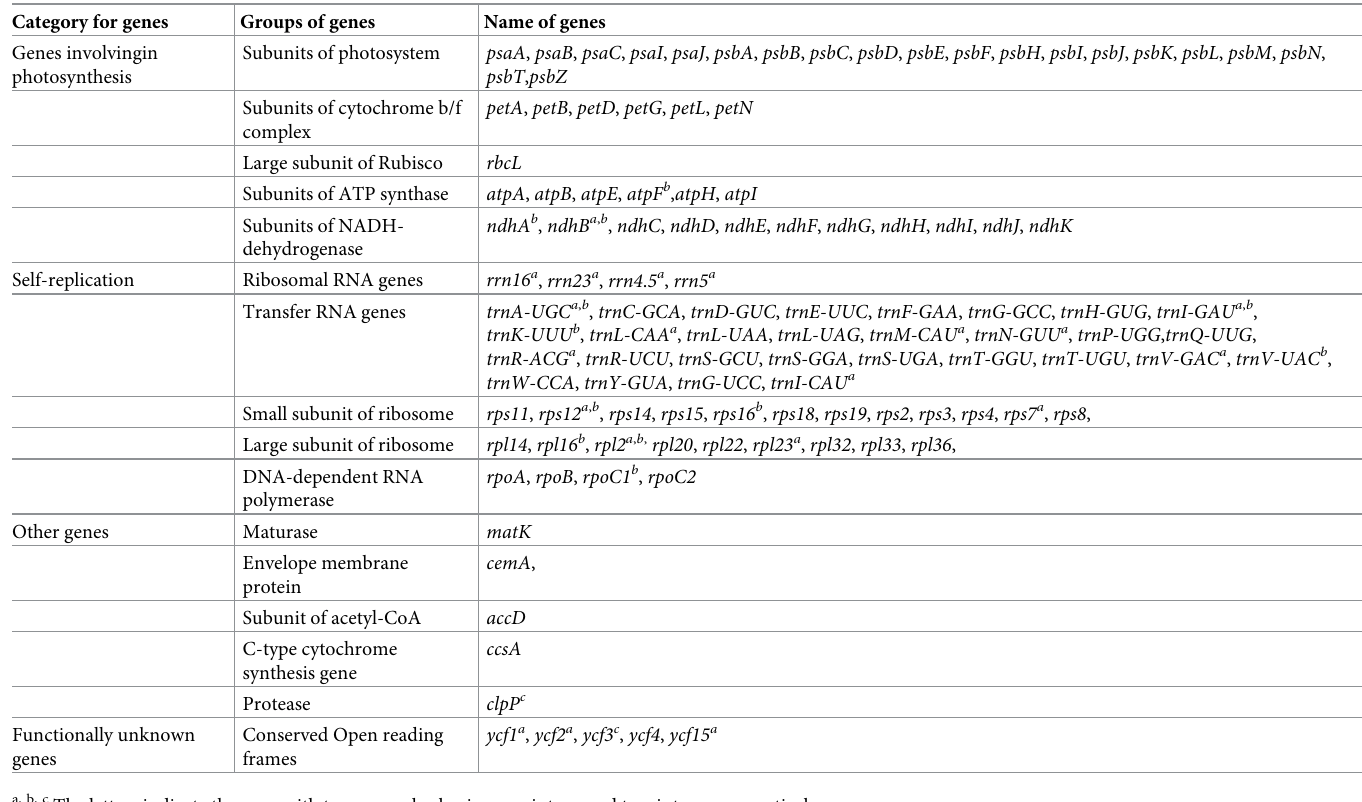
Table 2. Summary of assembled gene functions of Moricandia arvensis cp